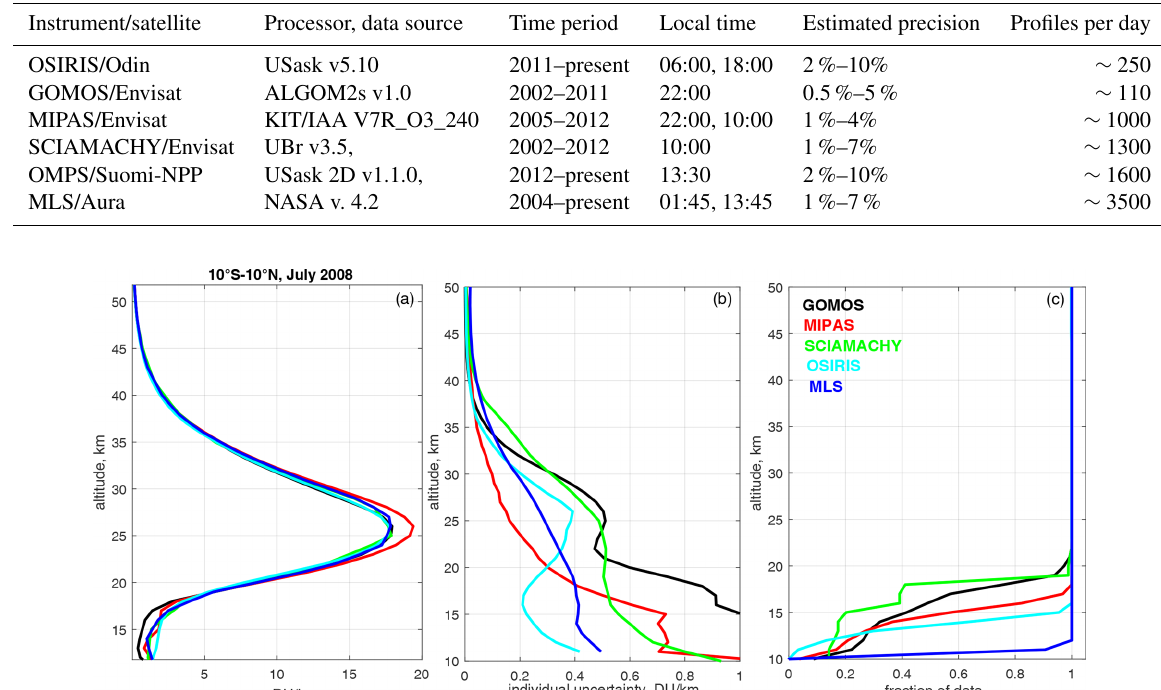
Figure 1. (a) Mean ozone profiles at 10 ◦ S–10 ◦ N in July 2008. (b) Uncertainty of individual ozone profiles. (c) Fraction of data (with respect to the data in the